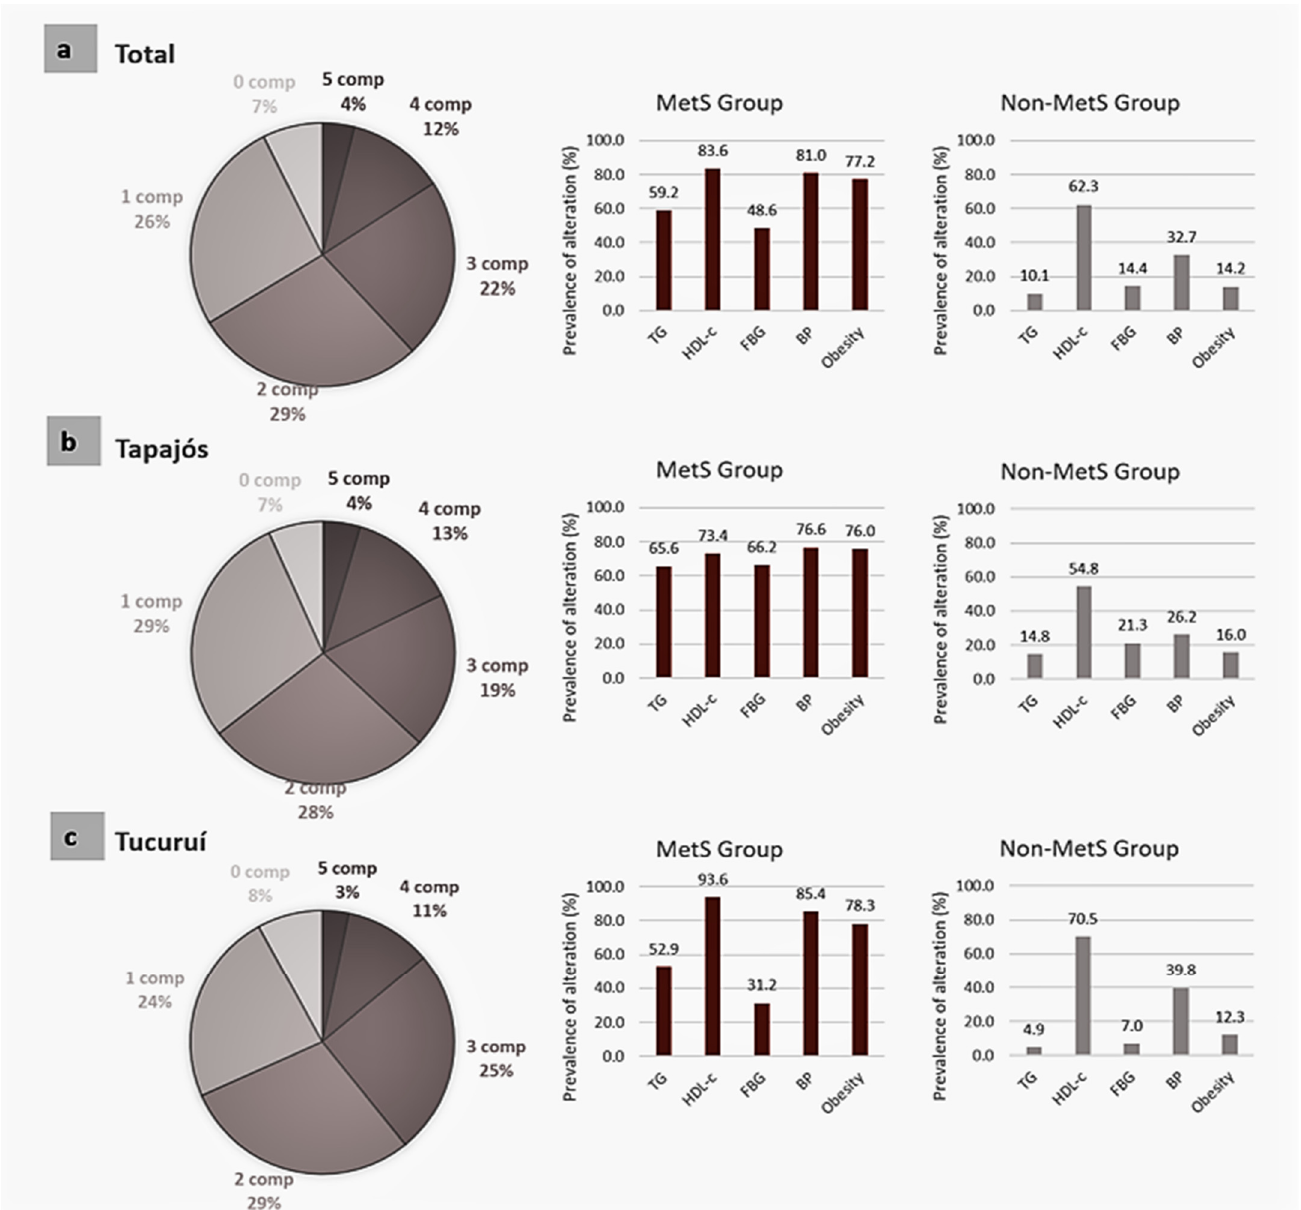
Figure 4. Analysis of metabolic syndrome (MetS) components (comp) for all participants (horizontal ( a )), and those from Tapajós (horizontal ( b )) and Tucuruí (horizontal ( c )) regions. Pie charts show the participants’ distribution with 0 to 5 altered components. Bar graphics indicate the frequency of each altered component (high triglycerides, TG; low HDL cholesterol, HDL-c; high fasting blood glucose, FBG; high blood pressure, BP; and obesity-considering waist circumference, or BMI when waist circumference was not available) in participants with MetS (MetS Group) and without it (Non-MetS Group).